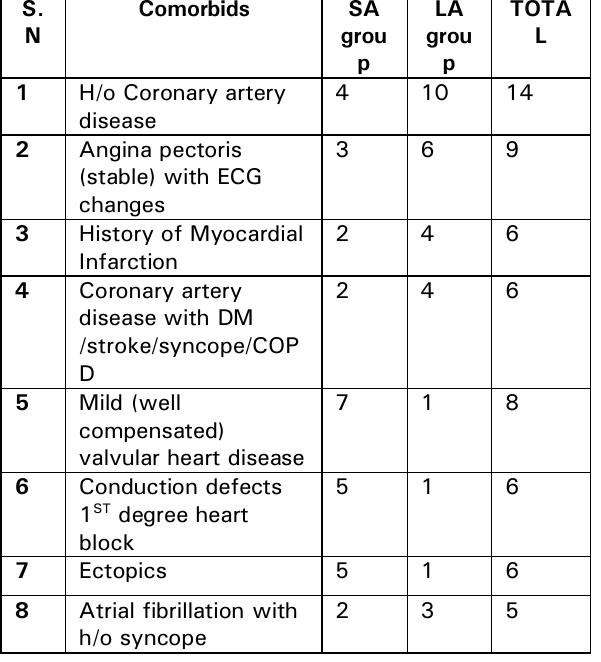
Table 2: Comorbid diseases